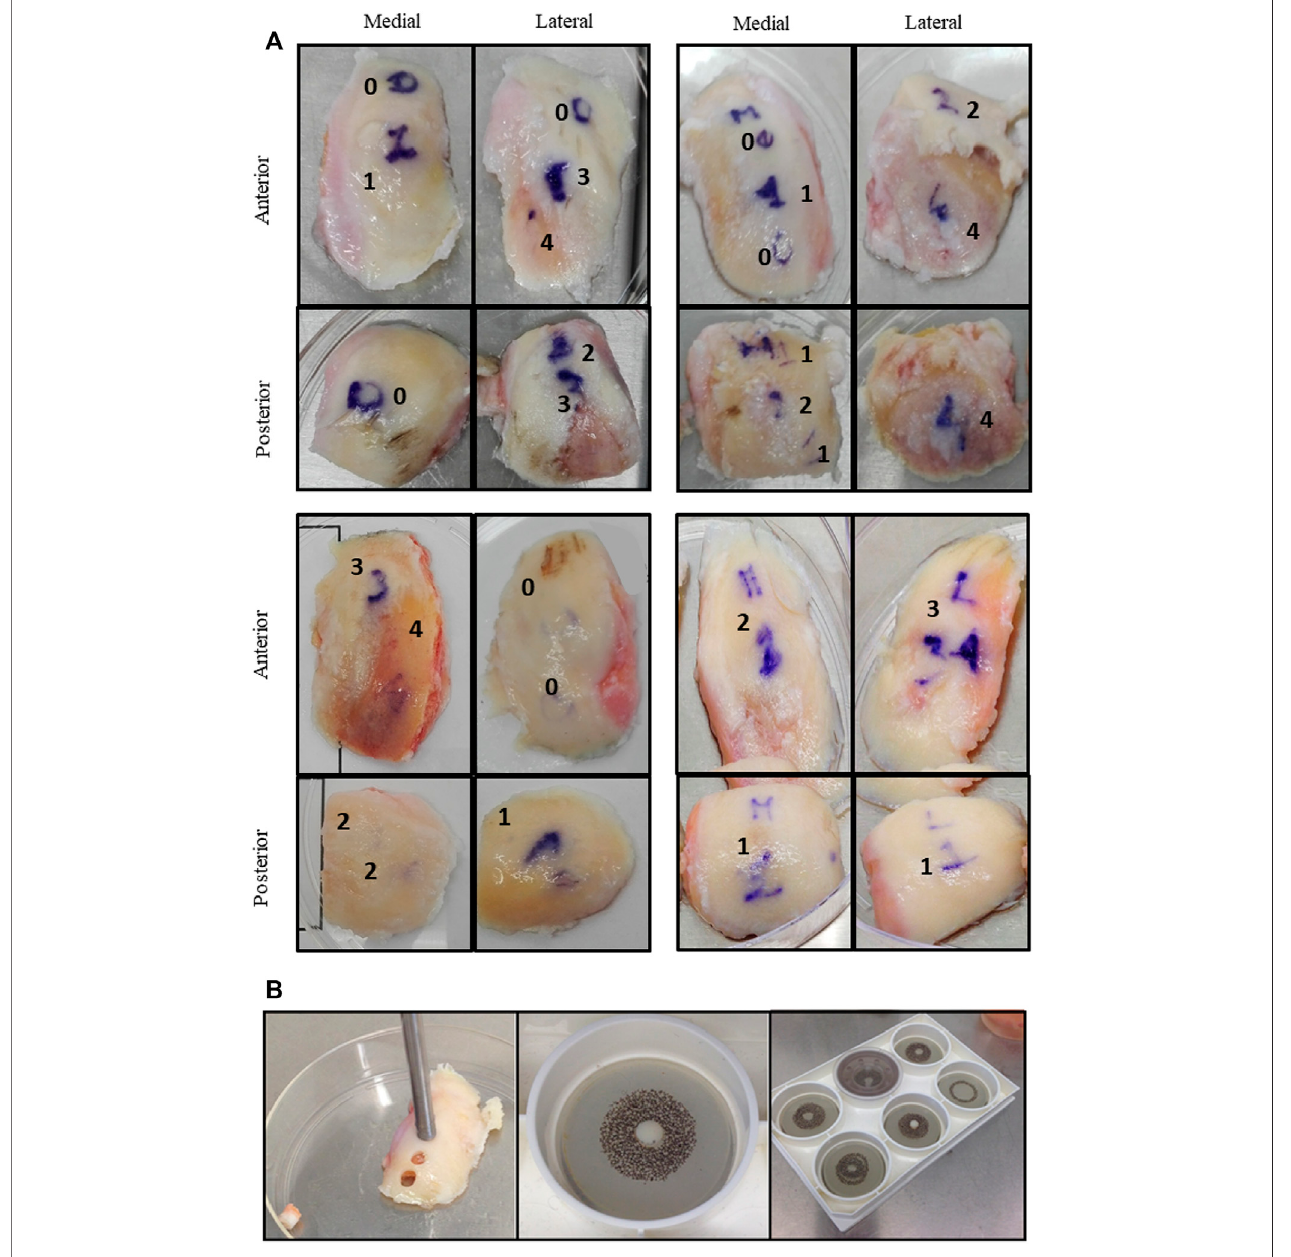
FIGURE 1 | (A) Cartilage explants from four representative donors. Images of surgical samples are shown. Condyles were divided in zones (anterior, posterior, medial, and lateral) and in areas with different macroscopic scores (from 0 to 4). (B) Each area was independently cored to obtain cartilage cylinders placed inside compression plates and exposed to uncon fi ned compression in the Flexcell bioreactor